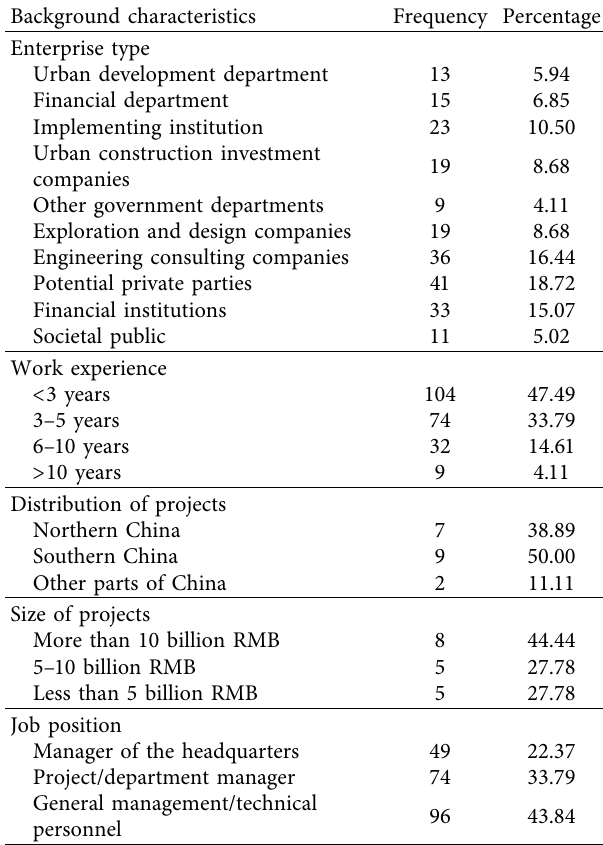
Table 1: Characteristics of